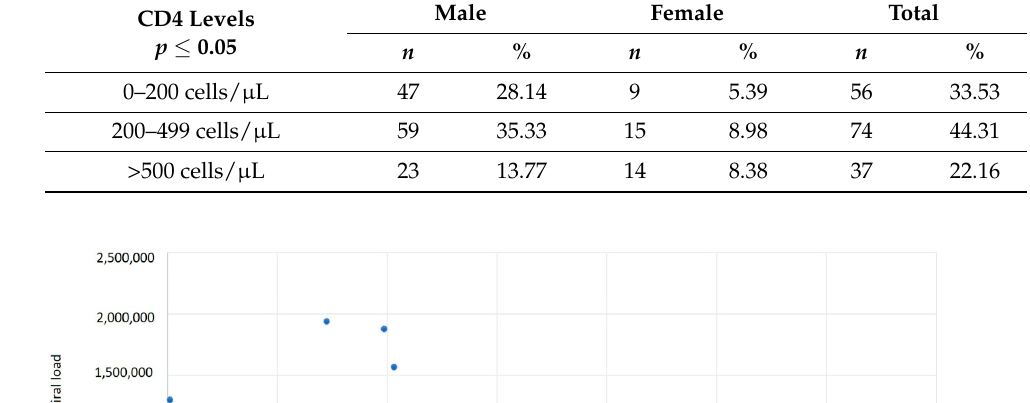
Table 10. Distribution by CD4+ T-lymphocyte level and sex, one month after ART.